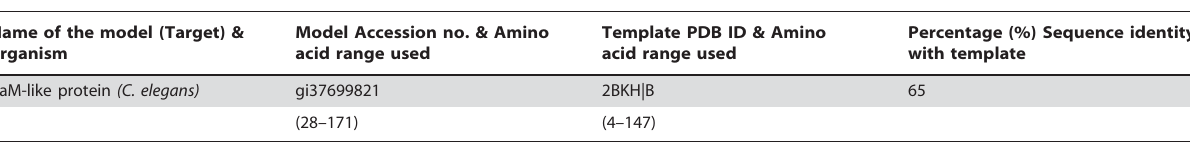
Table 1. Template and Target the sequences used for modelling.